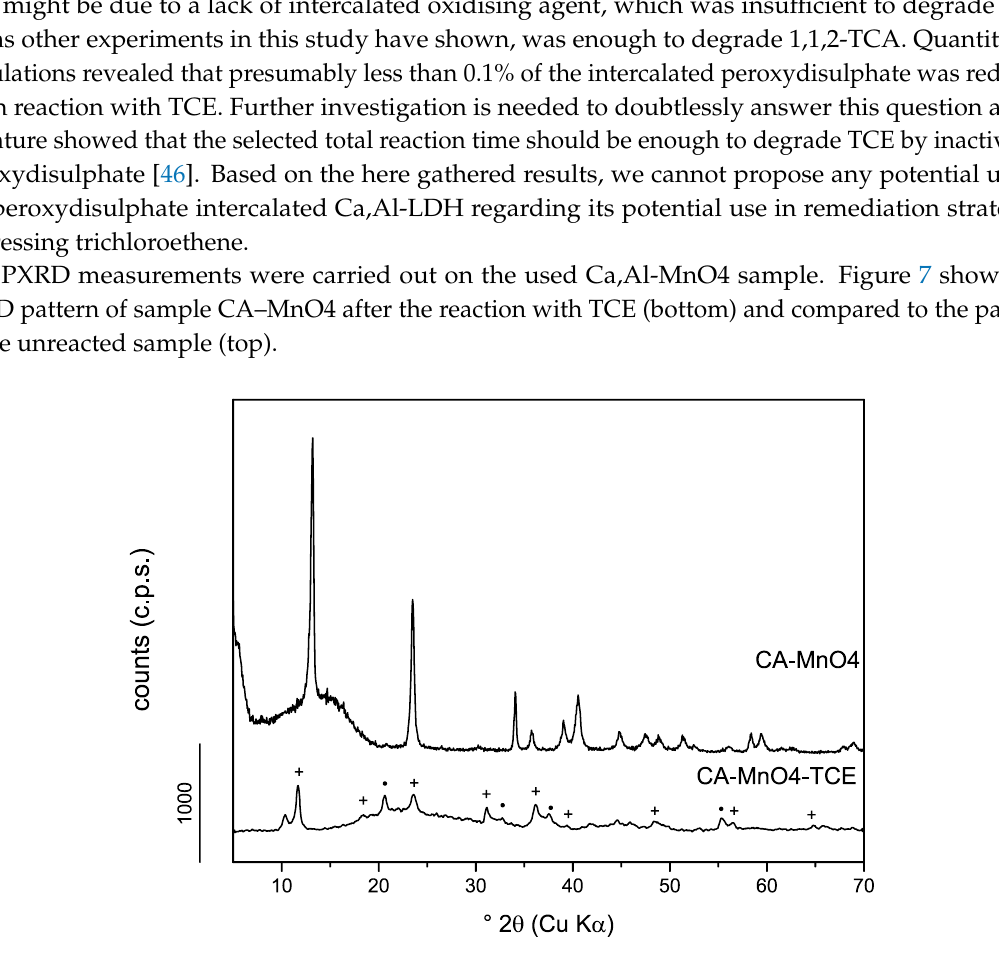
Figure 7. PXRD pattern of the reacted sample CA–MnO4 after experiments using TCE ( bottom ) compared to the pattern of the unreacted raw material ( top ). Peaks are labelled regarding their assigned mineral phases; (+) hydrocalumite and (∙) MnO 2.